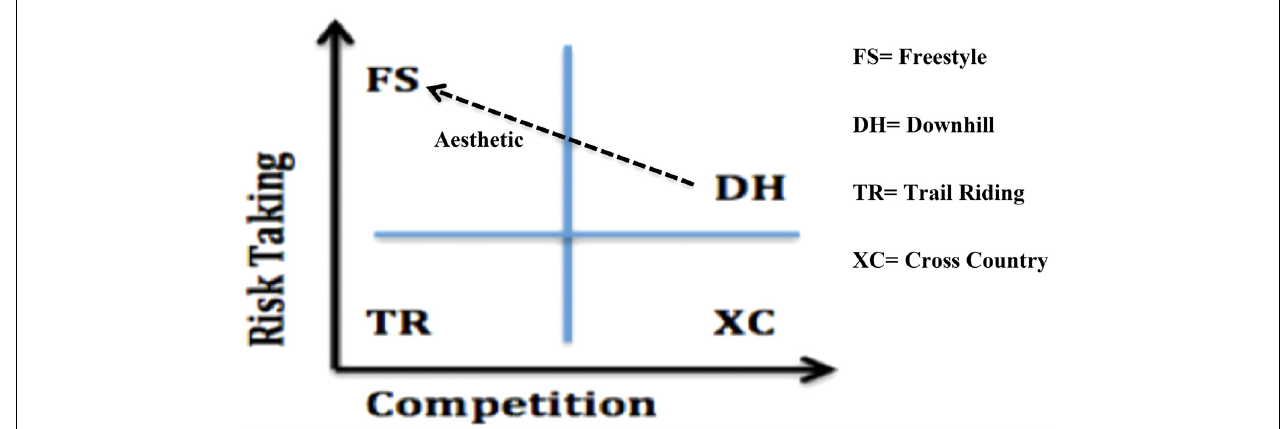
FIGURE 1 | A model of difference between formats of mountain